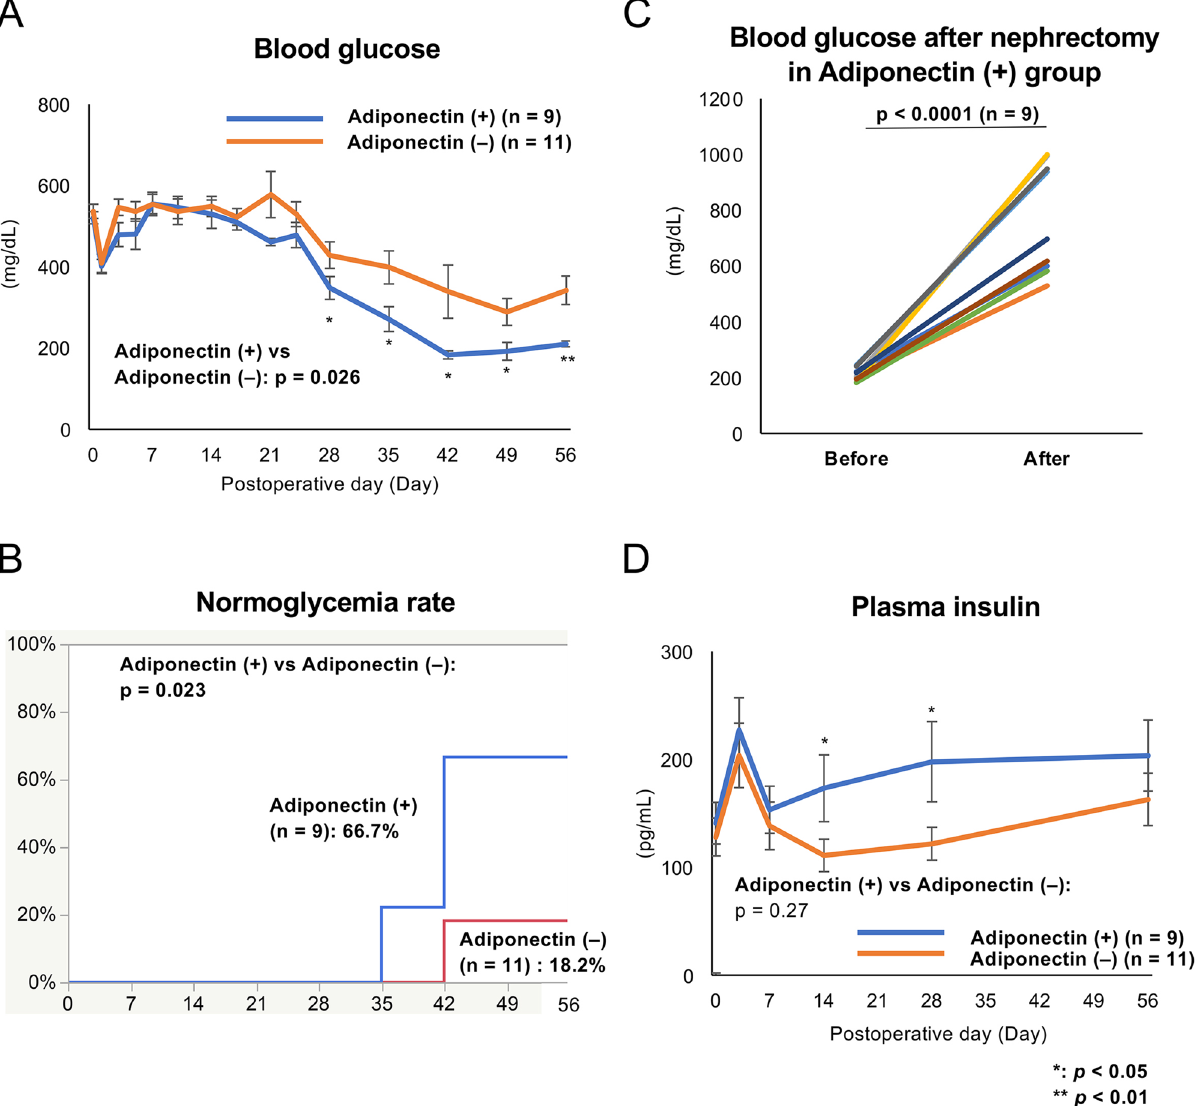
Figure 6. The therapeutic effect of adiponectin treatment in ITx. Blood glucose ( A ) and plasma insulin ( D ) levels after ITx in the islets treated with adiponectin (adiponectin (+), n = 9) and without adiponectin (adiponectin (−), n = 11). Normoglycemia was defined as a blood glucose level < 200 mg/dL. The rate of normoglycemia is shown in ( B ). The change of blood glucose level in the adiponectin (+) group before and after nephrectomy was also assessed ( C ). Data are presented as the mean ± standard error of the mean. A p -value < 0.05 was considered statistically significant. * p < 0.05, ** p < (Fig. 6D). On the other hand, there was no significant difference in changes of blood glucose levels in the glucose tolerance test (GTT) at POD 56 between the adiponectin (+) and adiponectin (−) groups ( p = 0.45; Supplemen- tal Fig. 4A). Furthermore, no difference in the value of the area under the curve for blood glucose levels in the GTT (AUC-GTT) at POD 56 was noted between the two groups (768.75 ± 34.76 vs. 712.25 ± 8.49 mg/dL × h; Supplemental Fig. 4B). Renal subcapsular ITx with an intraperitoneal injection of 1 mg/kg adiponectin was performed in two mice for further assessment. The blood glucose levels were not normalized during the observation period (Supplemen- tal Fig. 5A). The AUC-GTT of this group was higher compared with the adiponectin (+) group (799.96 ± 22.96 vs. 1,037.63 ± 8.43 mg/dL × h, p = 0.0002; Supplemental Fig. 5B), indicating that a single injection of adiponectin did not improve ITx outcomes. In summary, adiponectin treatment might reinforce the therapeutic effect of ITx, but its contribution appeared to be partial.